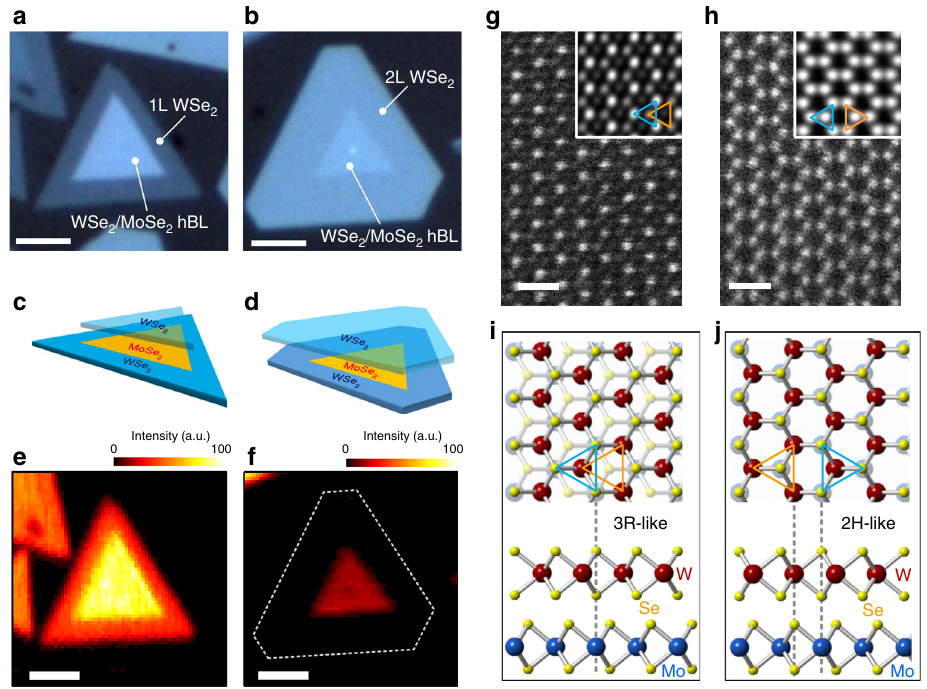
Fig. 1 WSe 2 /MoSe 2 hBLs with AA and AB stacking. a , b Optical images of hBLs with AA ( a ) and AB ( b ) stacking. The scale bar is 3 μ m. c , d Schematics of heterostructures shown in a and b , respectively. e , f SHG intensity mapping for the hBLs with AA ( e ) and AB ( f ) stacking. The scale bar is 3 μ m. g , h ADF STEM images of the hBLs with AA ( g ) and AB ( h ) stacking. The insets are fi ltered images. The scale bar is 0.5 nm. i , j Schematics of the top and side views of the atomic registries of AA ( i ) and AB ( j ) stacking, according to the ADF STEM results. The AA stacking corresponds to the 3R-like stacking ( i ), with Se atoms of WSe 2 on top of Mo atoms of MoSe 2 . The AB stacking corresponds to the 2H-like stacking ( j ), with W (Se) atoms of WSe 2 on top of Se (Mo) atoms of MoSe 2